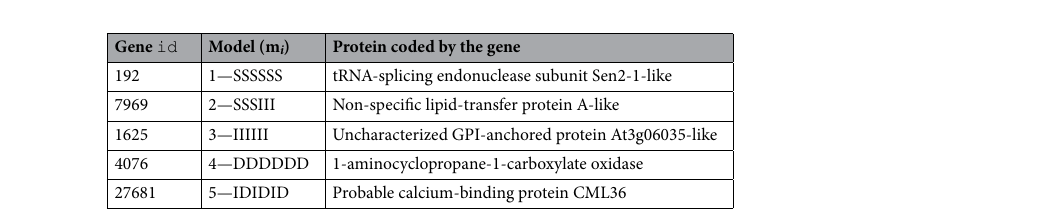
Table 2. Examples of 5 different ternary models ( m i ) for genes expressed in accession